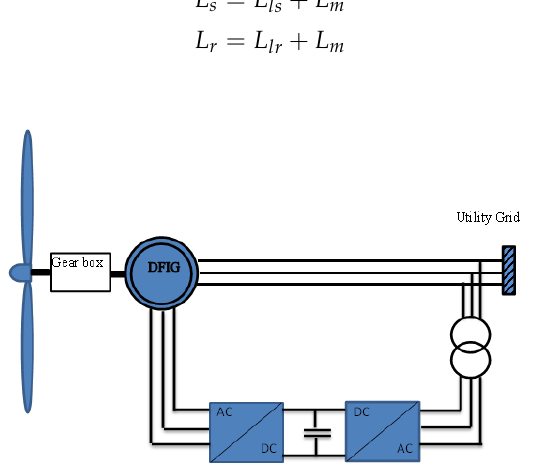
Figure 2. A typical configuration for a DFIG-based wind